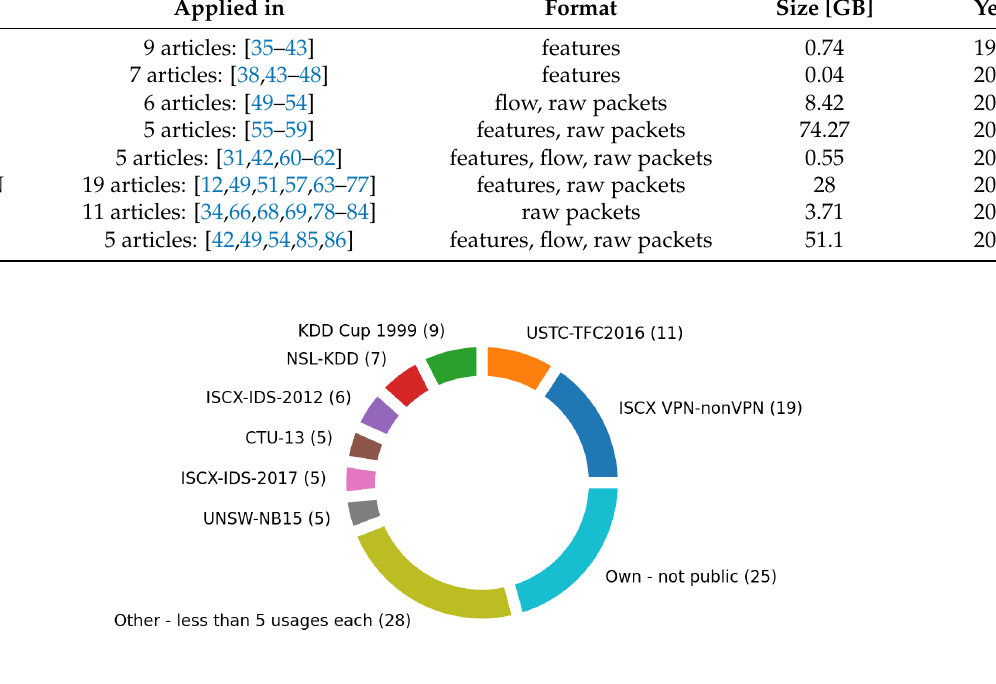
Figure 7. Popularity of the datasets within the reviewed articles. Digits in the brackets stand for the number of all occurrences of each